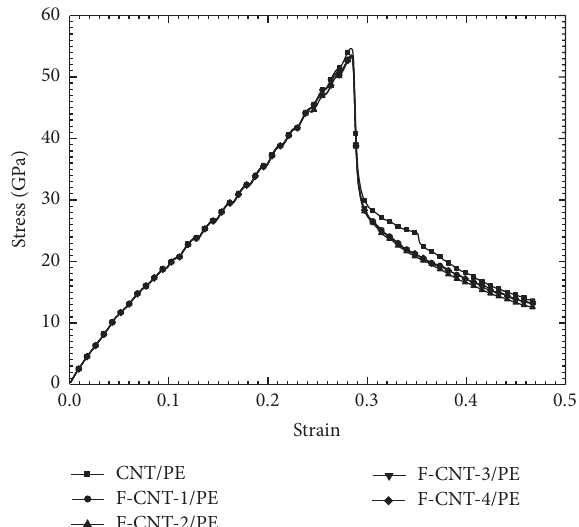
Figure 14: Variation of compression stress versus strain of CNT/PE composites with different volume fractions of CNTs.